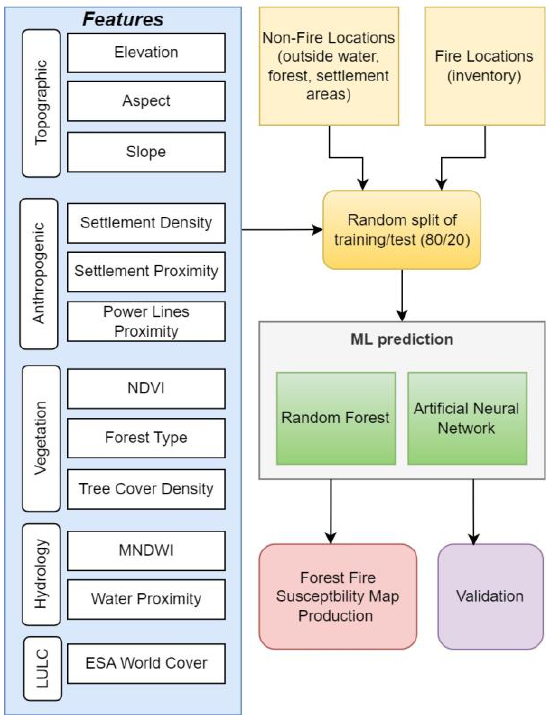
Figure 4 . The workflow of the study.